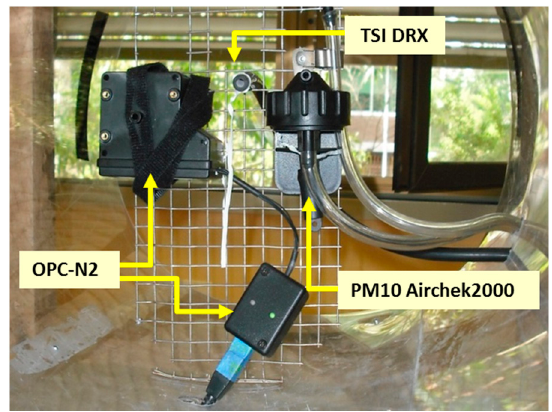
Figure 6. Layout of all monitoring equipment and sensors used to obtain the particle correction factor.